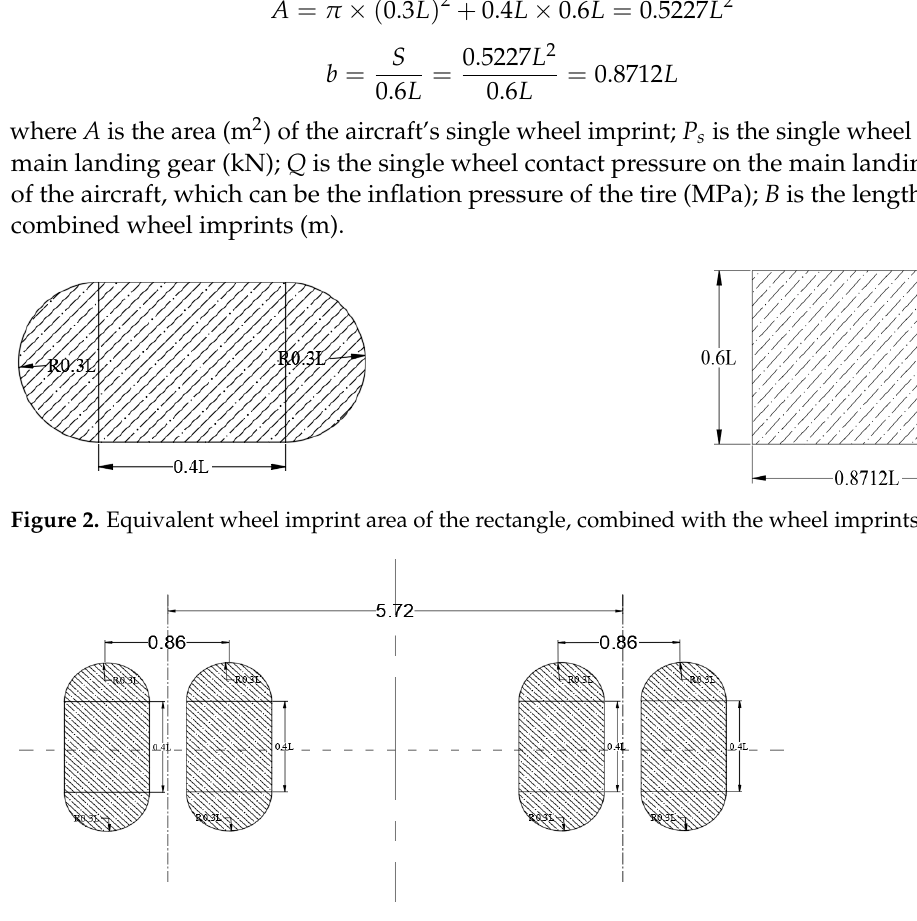
Figure 3. Schematic diagram of the wheel imprint of the main landing gear acting on airport pave- ment.